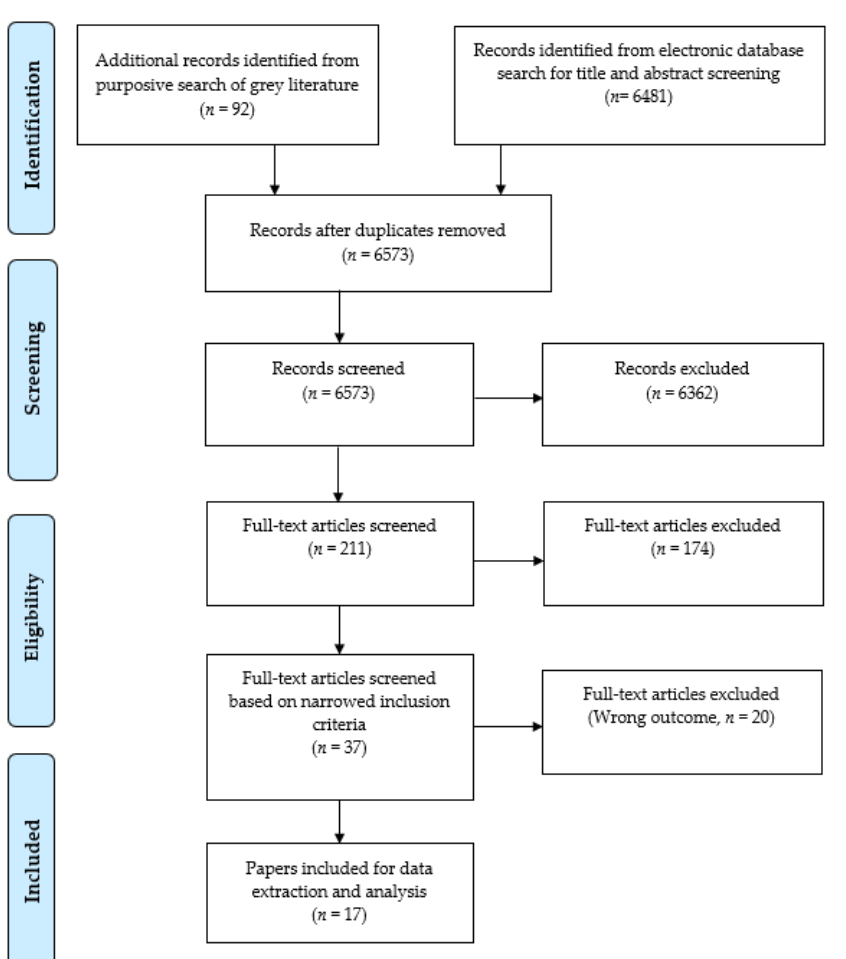
Figure 1. PRISMA flowchart of the CDW violence and health study selection .